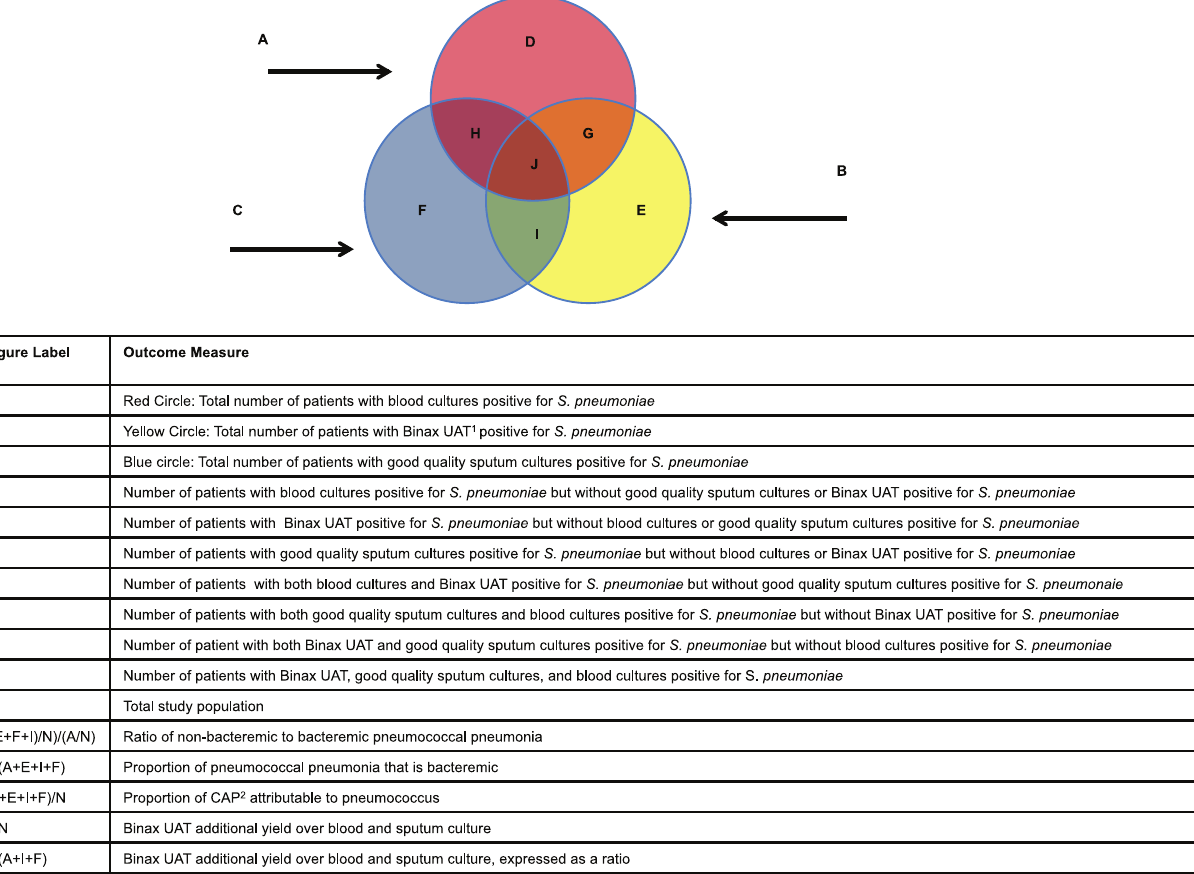
Figure 2. The relationship in diagnostic test yield of blood culture, sputum culture, and the Binax UAT 2 .